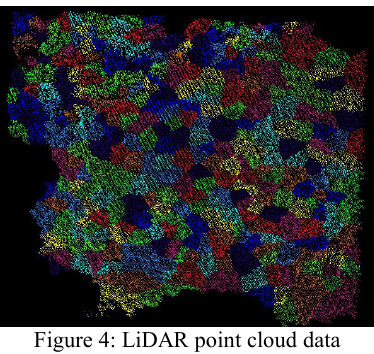
Figure 4: LiDAR point cloud data